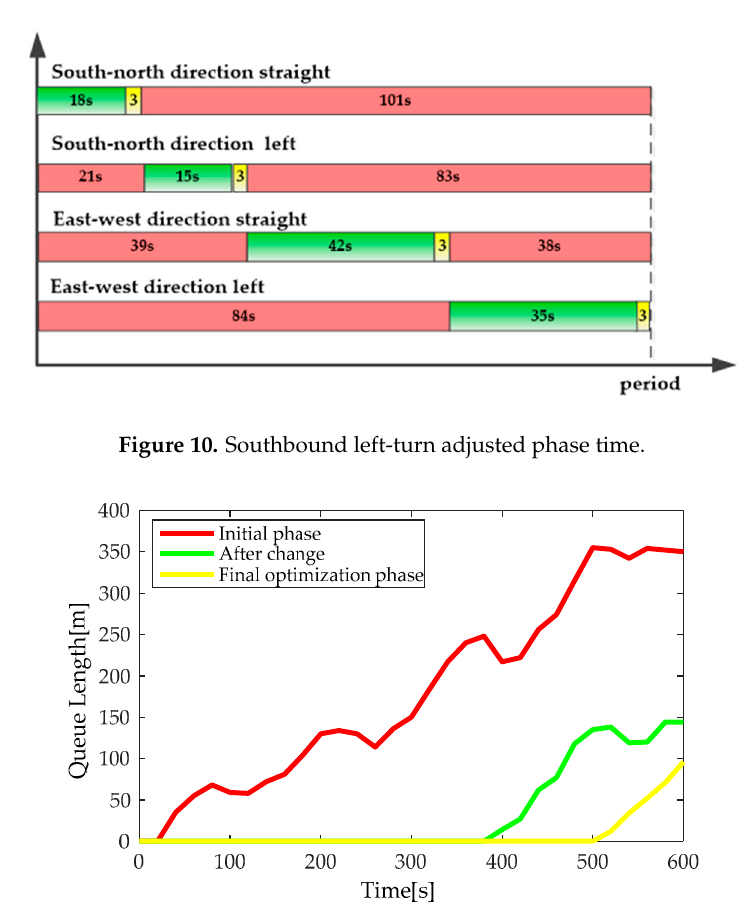
Figure 10. Southbound left-turn adjusted phase time.